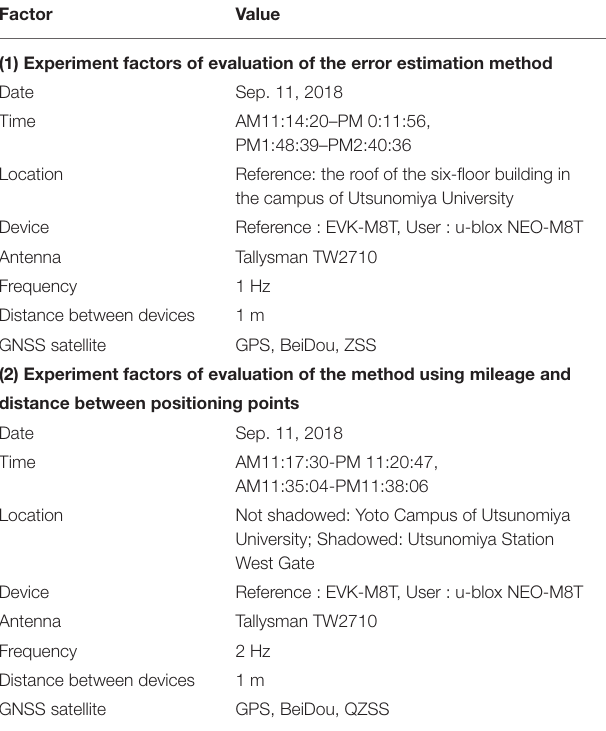
TABLE 3 | Experiment factors of the proposed